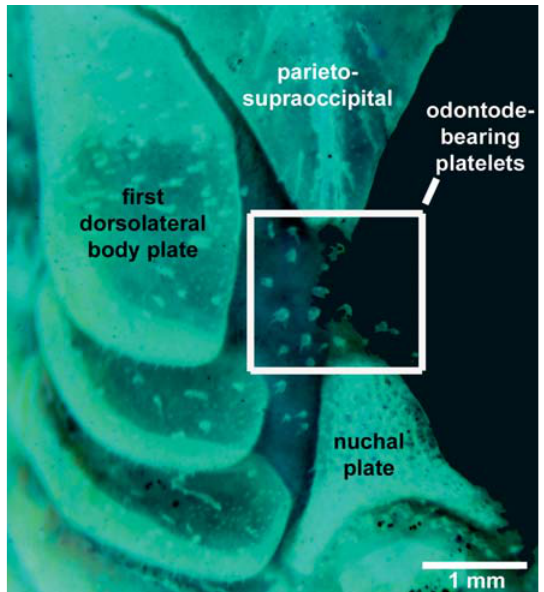
Fig. 5. Detail of top of head of Scleromystax salmacis , paratype, MCP 29299, 33.2 mm SL, showing minute odontode- bearing platelets between posterior process of parieto-su- praoccipital and nuchal